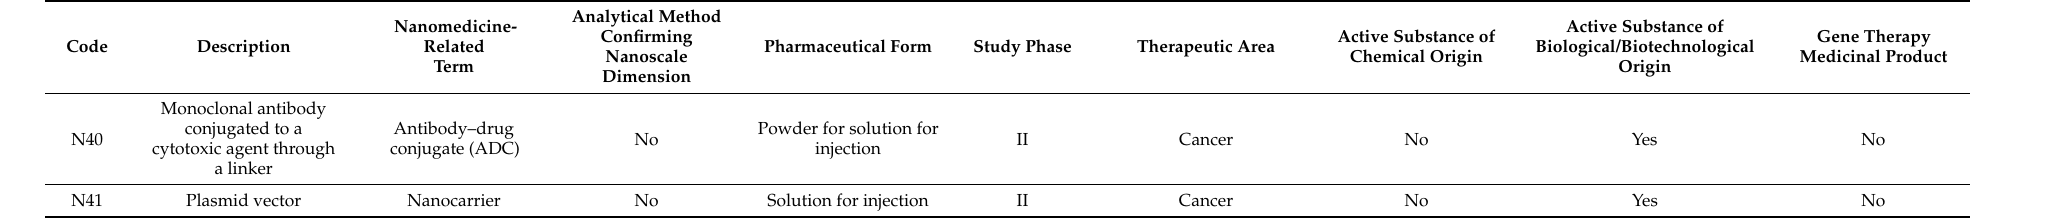
Table A2. Nanomedicines detected in CTs authorized in